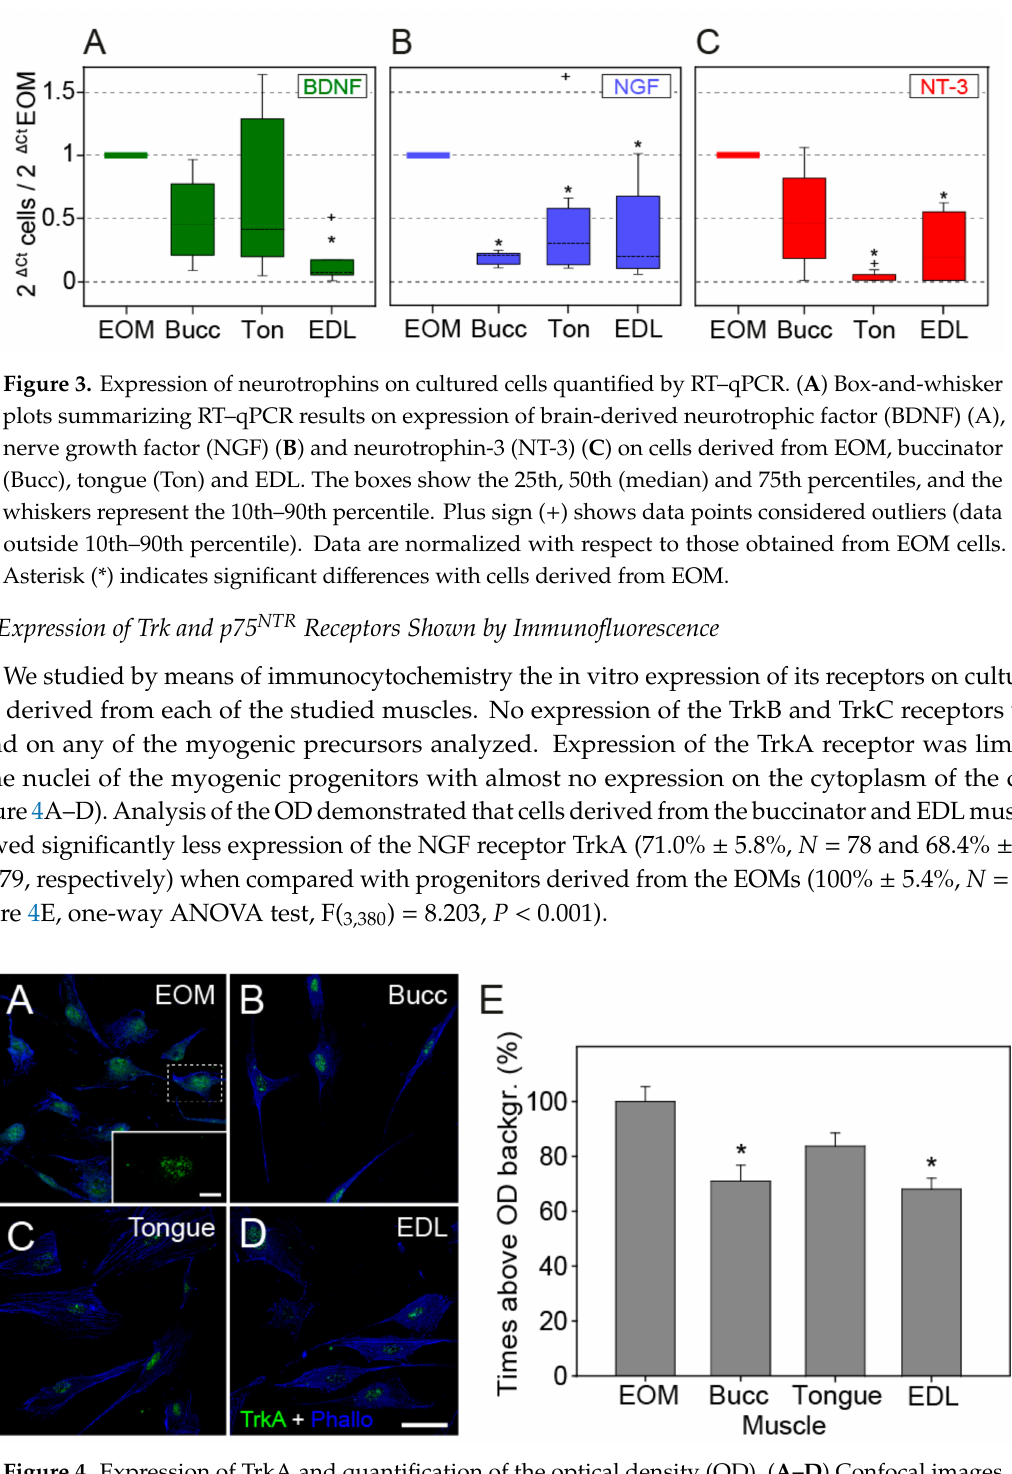
Figure 4. Expression of TrkA and quantification of the optical density (OD). ( A–D ) Confocal images showing the immunostaining for TrkA receptor (green) and the cytoplasm stained with phalloidin (blue). Images A to D correspond to cells obtained from EOM, buccinator (Bucc), tongue and EDL, respectively. Scale bars: 40 µ m. ( E ) Bar charts comparing mean ± SEM times above OD background for TrkA immunofluorescence in cells obtained from each muscle, expressed as a percentage with respect to EOM-derived cell values (number of cells analysed: 126, 78, 101 and 79 for EOM, buccinators, tongue and EDL, respectively). The asterisks (*) indicate significant di ff erences on the expression of this receptor in cells derived from buccinator and EDL when compared with